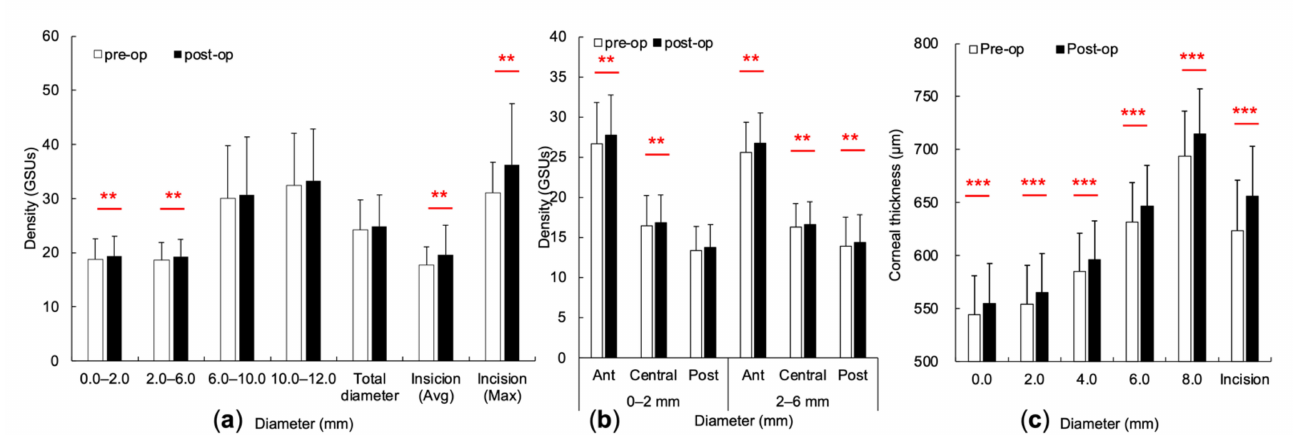
Figure 4. Changes in corneal optical density and corneal thickness regarding concentric diameter and incisional site after cataract surgery. ( a ) Comparison of the corneal optical density (COD) at the concentric diameter and incisional site. ( b ) The concentric CODs in different layers of the cornea at annuli 0.0 to 2.0 mm and 2.0 to 6.0 mm. ( c ) The concentric corneal thickness at zones 0.0 mm, 2.0 mm, 4.0 mm, 6.0 mm, 8.0 mm, and incisional site. ** p < 0.01, and *** p < 0.001, compared to the preoperative